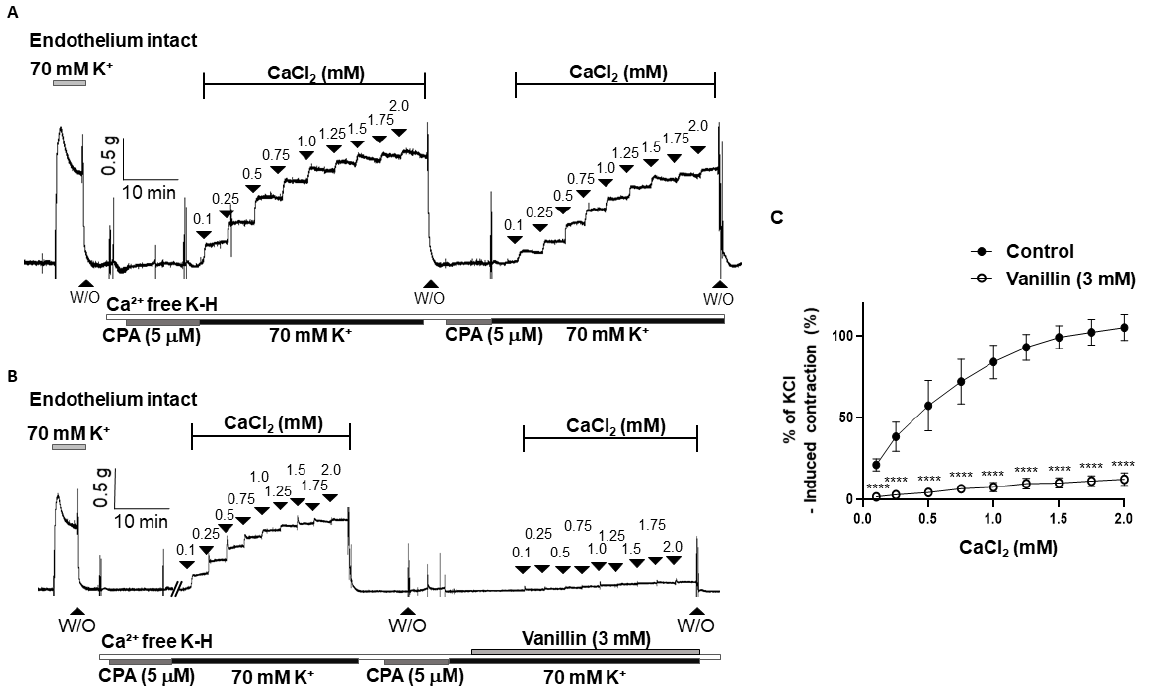
Figure 5. Vanillin inhibited extracellular Ca 2+ -induced vascular contraction. Representative traces showing the contraction responses by repeated addition of Ca 2+ (0.1–2.0 mM) in the absence of vanillin (3 mM, ( A )) and in the presence of vanillin (3 mM, ( B )). Statistical analysis of contraction induced by CaCl 2 in the mesenteric arteries with or without vanillin ( C ). Mean ± SD ( n = 7). **** p < 0.0001 (W/O: wash out; CPA: cyclopiazonic acid).